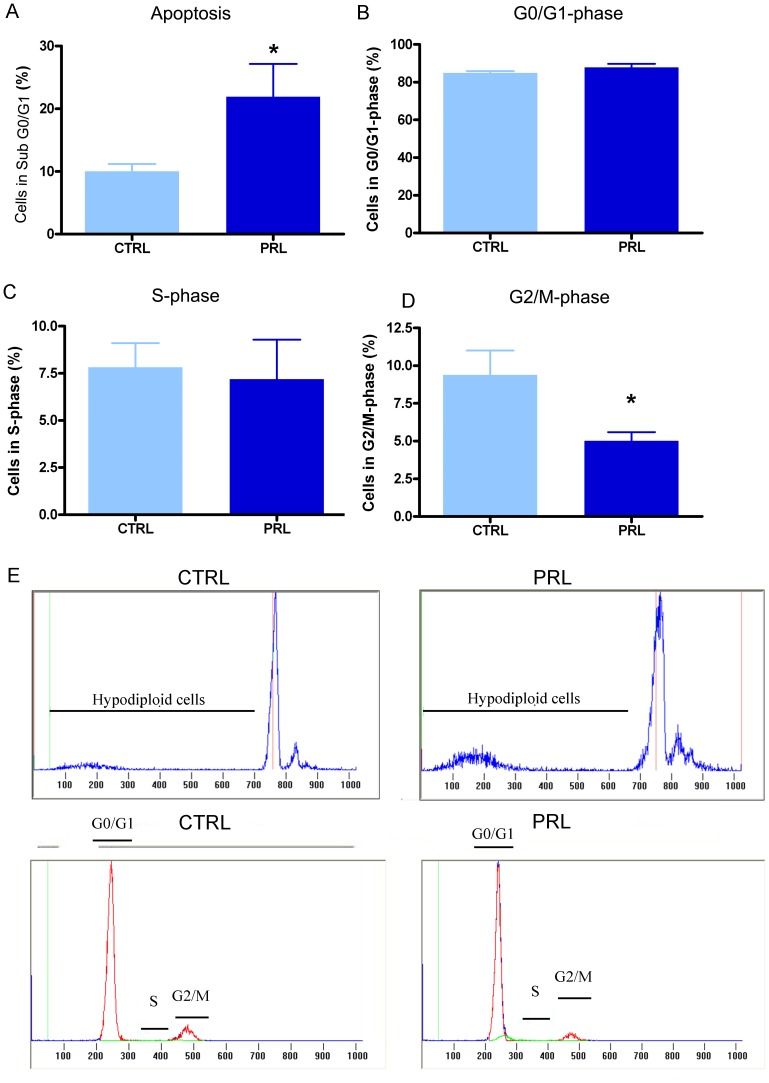
PRL increases anterior pituitary cells apoptosis in vivo and decreases the percentage of total anterior pituitary cells in G2/M-phase.Ovariectomized rats (n = 12 rats/group) were injected with oPRL (1 mg/kg, 6 h) or saline. A: Apoptosis was determined as the percentage of hypodiploid cells, using PI and FACS. Each column represents the mean ± SEM of the percentage of sub G0–G1 cells. *p<0.05 vs. respective control animals injected with vehicle, Student's t test. B–D: Cell cycle was analyzed by FACS using PI. Each column represents the mean ± SEM of the percentage of cells in G0/G1-phase (B), cells in S-phase (C) and cells in G2/M-phase (D). * p<0.05 vs. control animals injected with vehicle, Student's t test. E: Representative histograms showing hypodiploidy or cells in each cell cycle stage in CTRL and oPRL-treated animals.